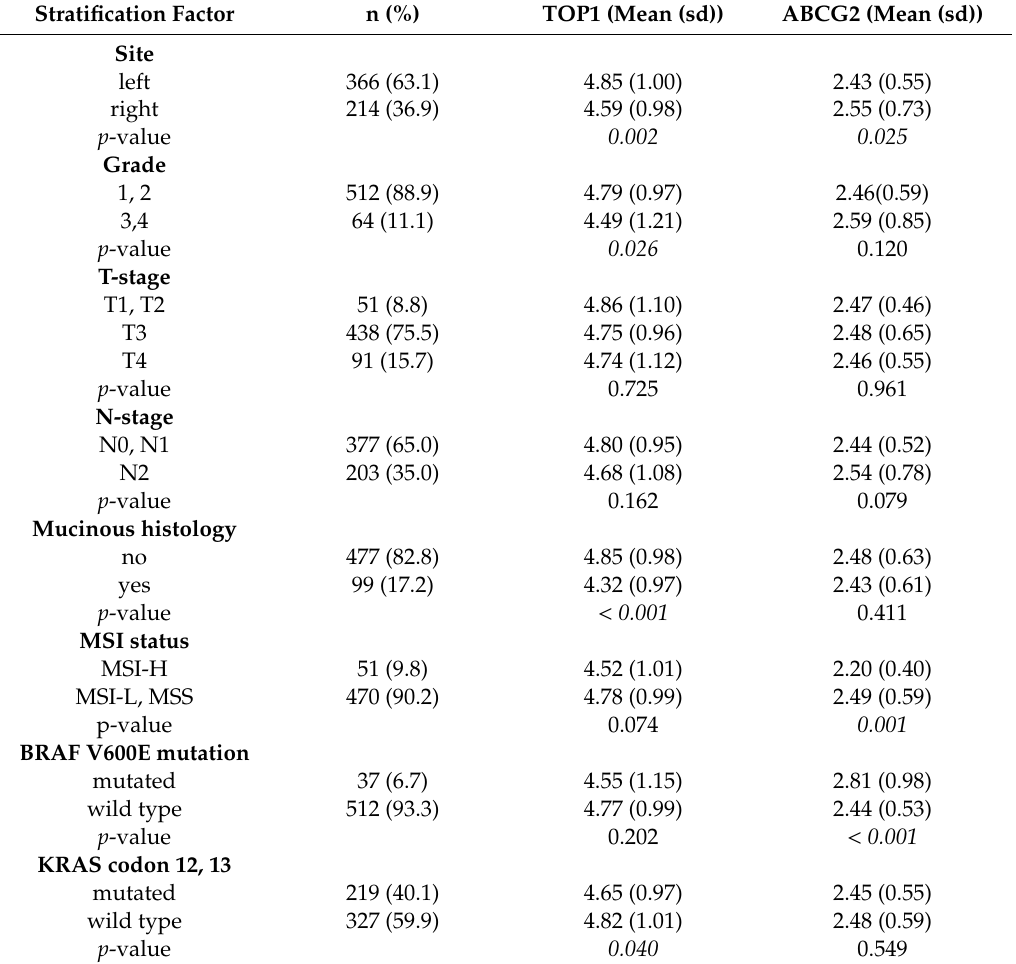
Table 2. Comparison of expression levels between various stratifications in the study subpopulation for ABCG2 and TOP1 genes, respectively. For each gene, the mean and standard deviation of the expression levels (log2) are indicated and the corresponding p-values from Student’s t -test (significant are emphasized by italic) for binary categories and ANOVA for multiple